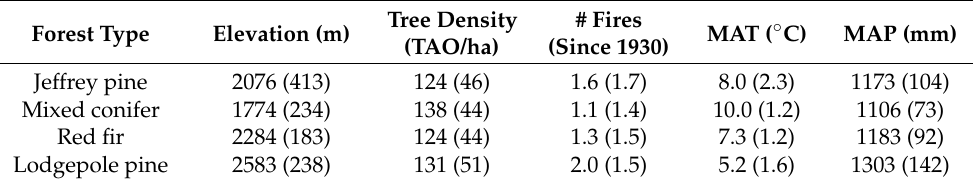
Table 2. Mean (standard deviation) elevation, forest density, number (#) of fires, mean annual temperature (MAT), and mean annual precipitation (MAP) across the dominant forest types in Yosemite NP.